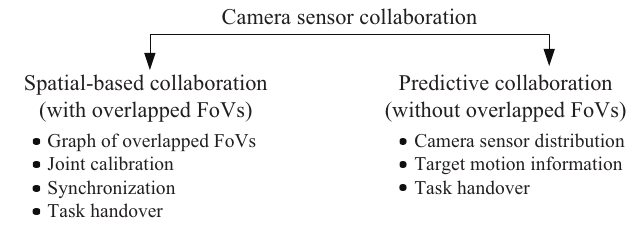
Figure 6. Camera Sensor Collaboration Schemes in